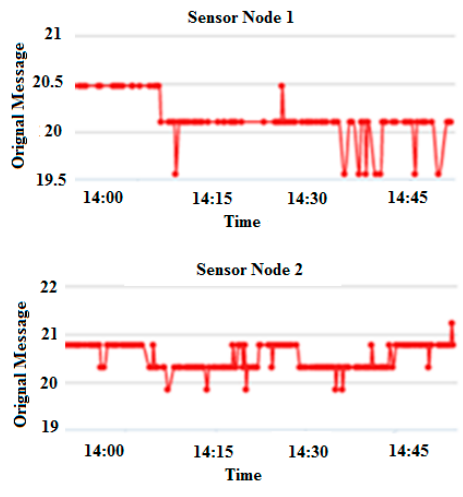
Figure 9. Original message from sensor node 1 and sensor node 2.